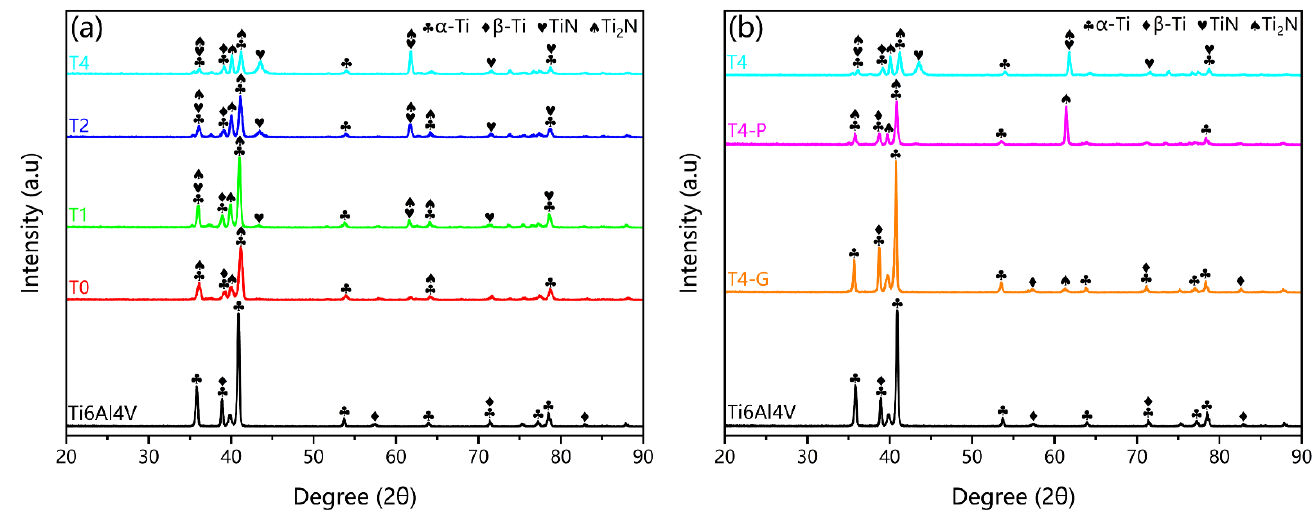
Figure 2. ( a ) The XRD patterns of the untreated Ti6Al4V, T0, T1, T2, and T4 samples; ( b ) The XRD patterns of the untreated Ti6Al4V, T4-G, T4-P, and T4